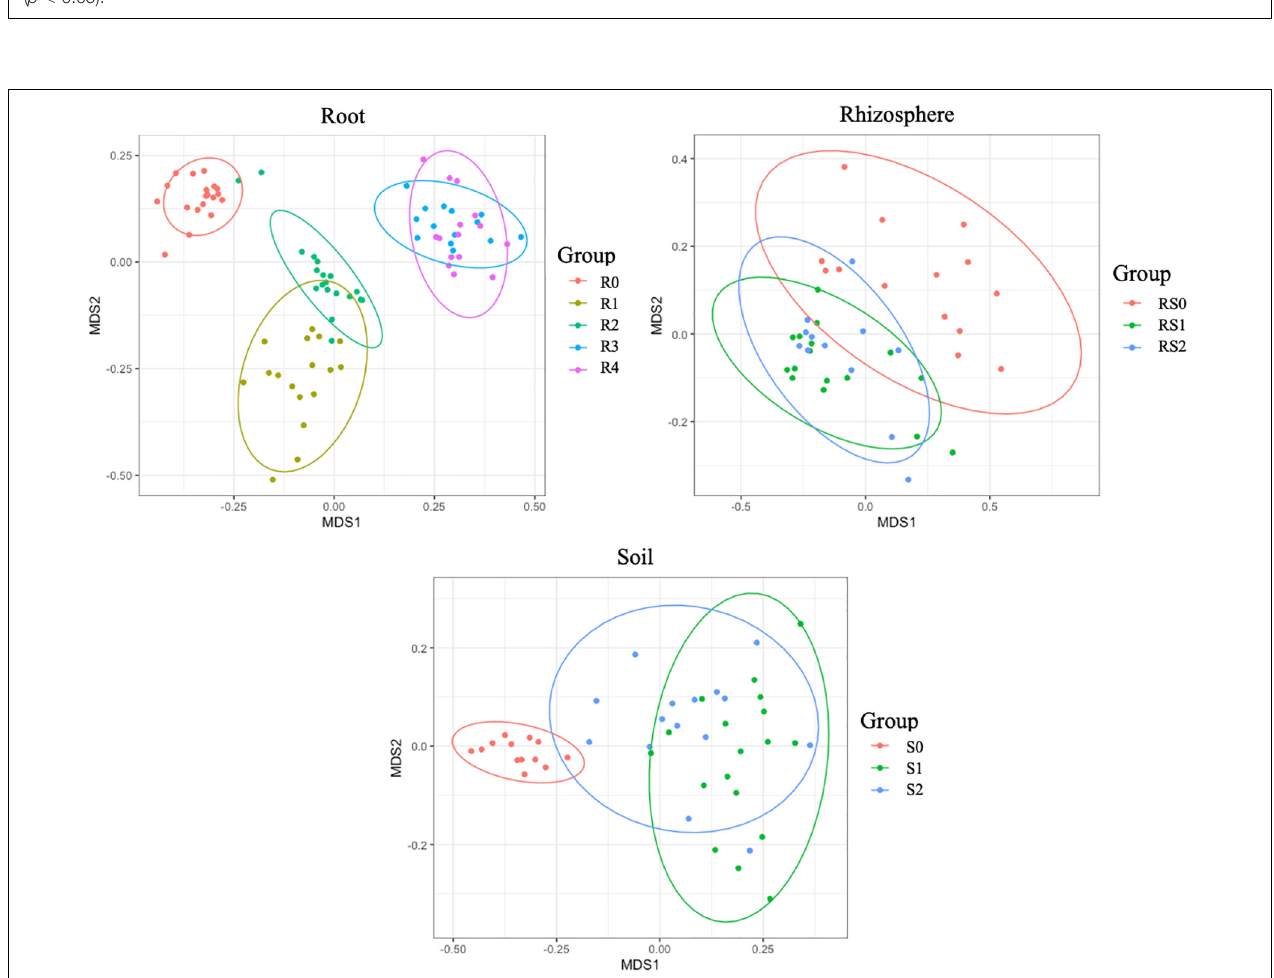
FIGURE 3 | Non-metric multidimensional scaling (NMDS) of bacterial communities. The difference between communities based on Bray–Curtis distances.